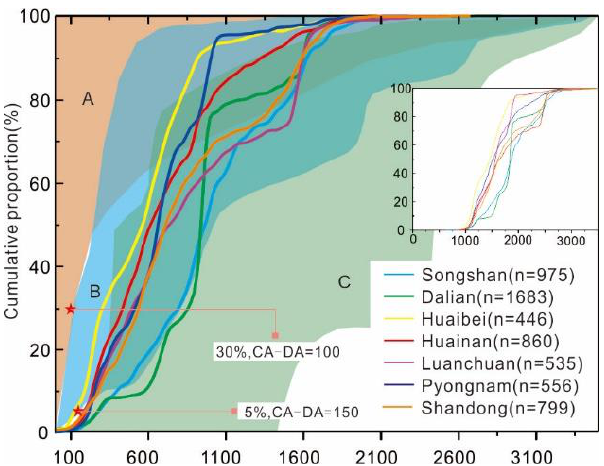
Figure 9. Detrital zircon age cumulative probability diagram for early Neoproterozoic sedimentary successions in NCC [82]. The reported data are the same as compiled in Figure 3 and also are